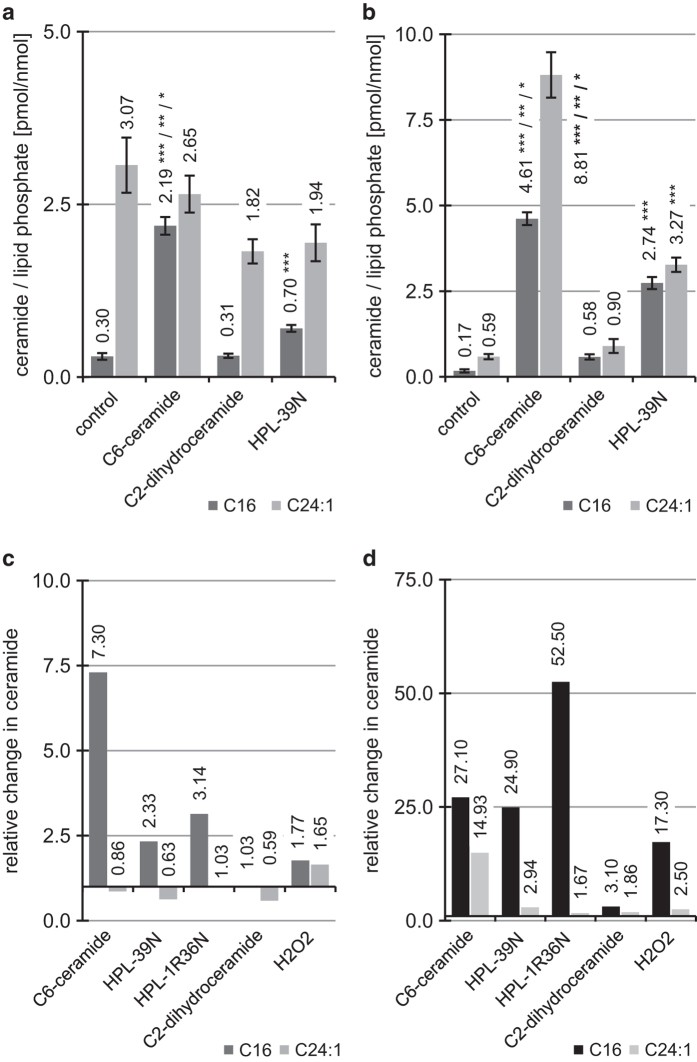
Induction and quantification of selected individual ceramide species in human macrophages and relative C16- and C24:1-ceramide concentrations after stimulation with compounds indicated. (a) Stimulation of C16- and (b) C24:1-ceramide concentration in macrophages after 4 and 7 h treatment with 10 μM exogenous C6-ceramide (1), 10 μM HPL-39N (3), 10 μM C2-dihydroceramide (4), shown as mean±S.E., n=3. One-way ANOVA in combination with post hoc t-tests and Bonferroni's correction for multiple testing, P<0.0001 (one-way ANOVA); significant with P<0.05: *** versus control, ** versus C2-dihydroceramide (4), * versus HPL-39N (3). (c) Relative ceramide concentrations after 4 h and (d) 7 h stimulation. Relative ceramide concentrations are calculated based on data derived from a and b, and Figures 4c and d. H2O2 data obtained in experiments resulting in a and b. Values result from the ratios obtained from the ceramide content in response to the test agent versus ceramide content of untreated control (same incubation conditions, as indicated in Figures 3a and b, and Figures 4c and d. C6-ceramide data derived from 8 h incubation.